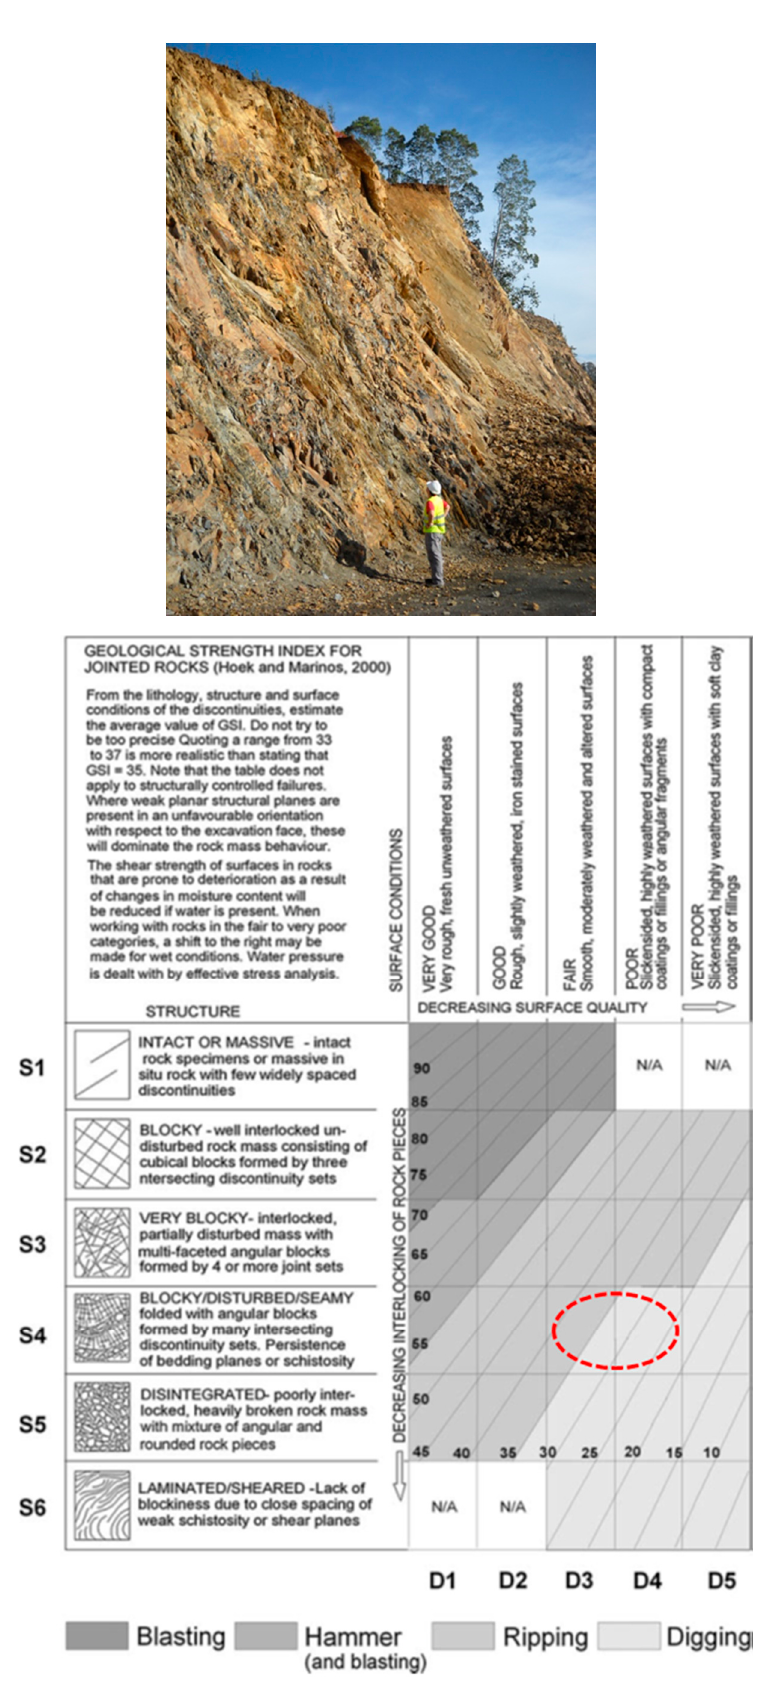
Figure 2. Excavatability of the shale rock mass for I s < 3 according to Tsiambaos and Saroglou [41].